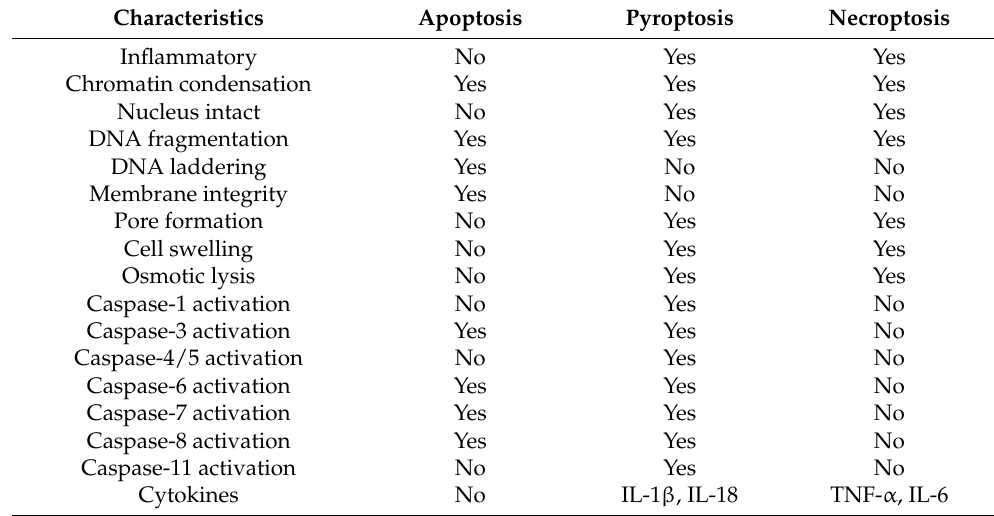
Table 1. Similarities and differences among apoptosis, pyroptosis and